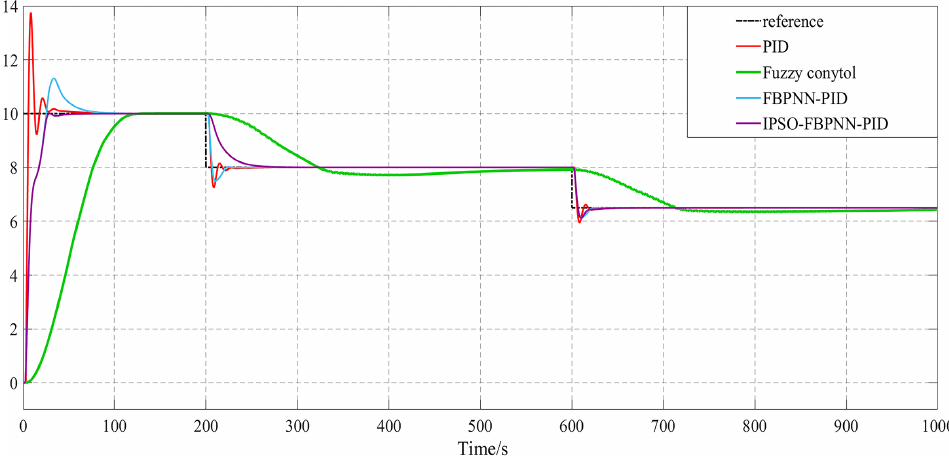
Figure 13. Simulation comparison and analysis diagram of different controllers.